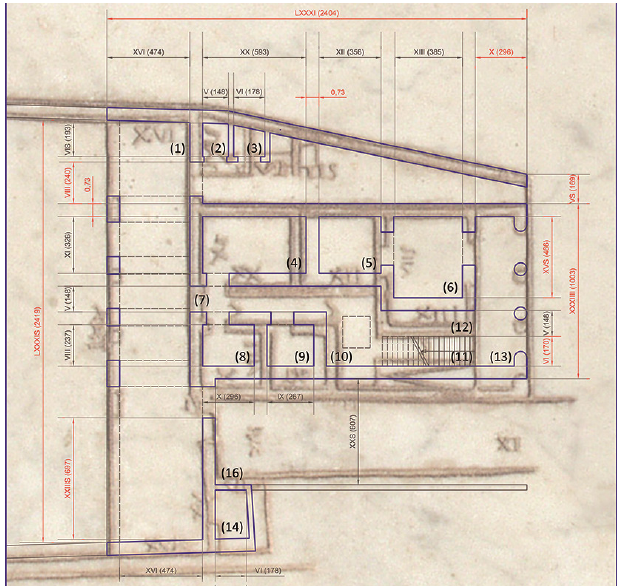
Figure 2. Edificium custodiae . Graphic comparison between the data obtained by superimposing the lines engraved on the marble and the quotas in Roman figures for the ground floor (see